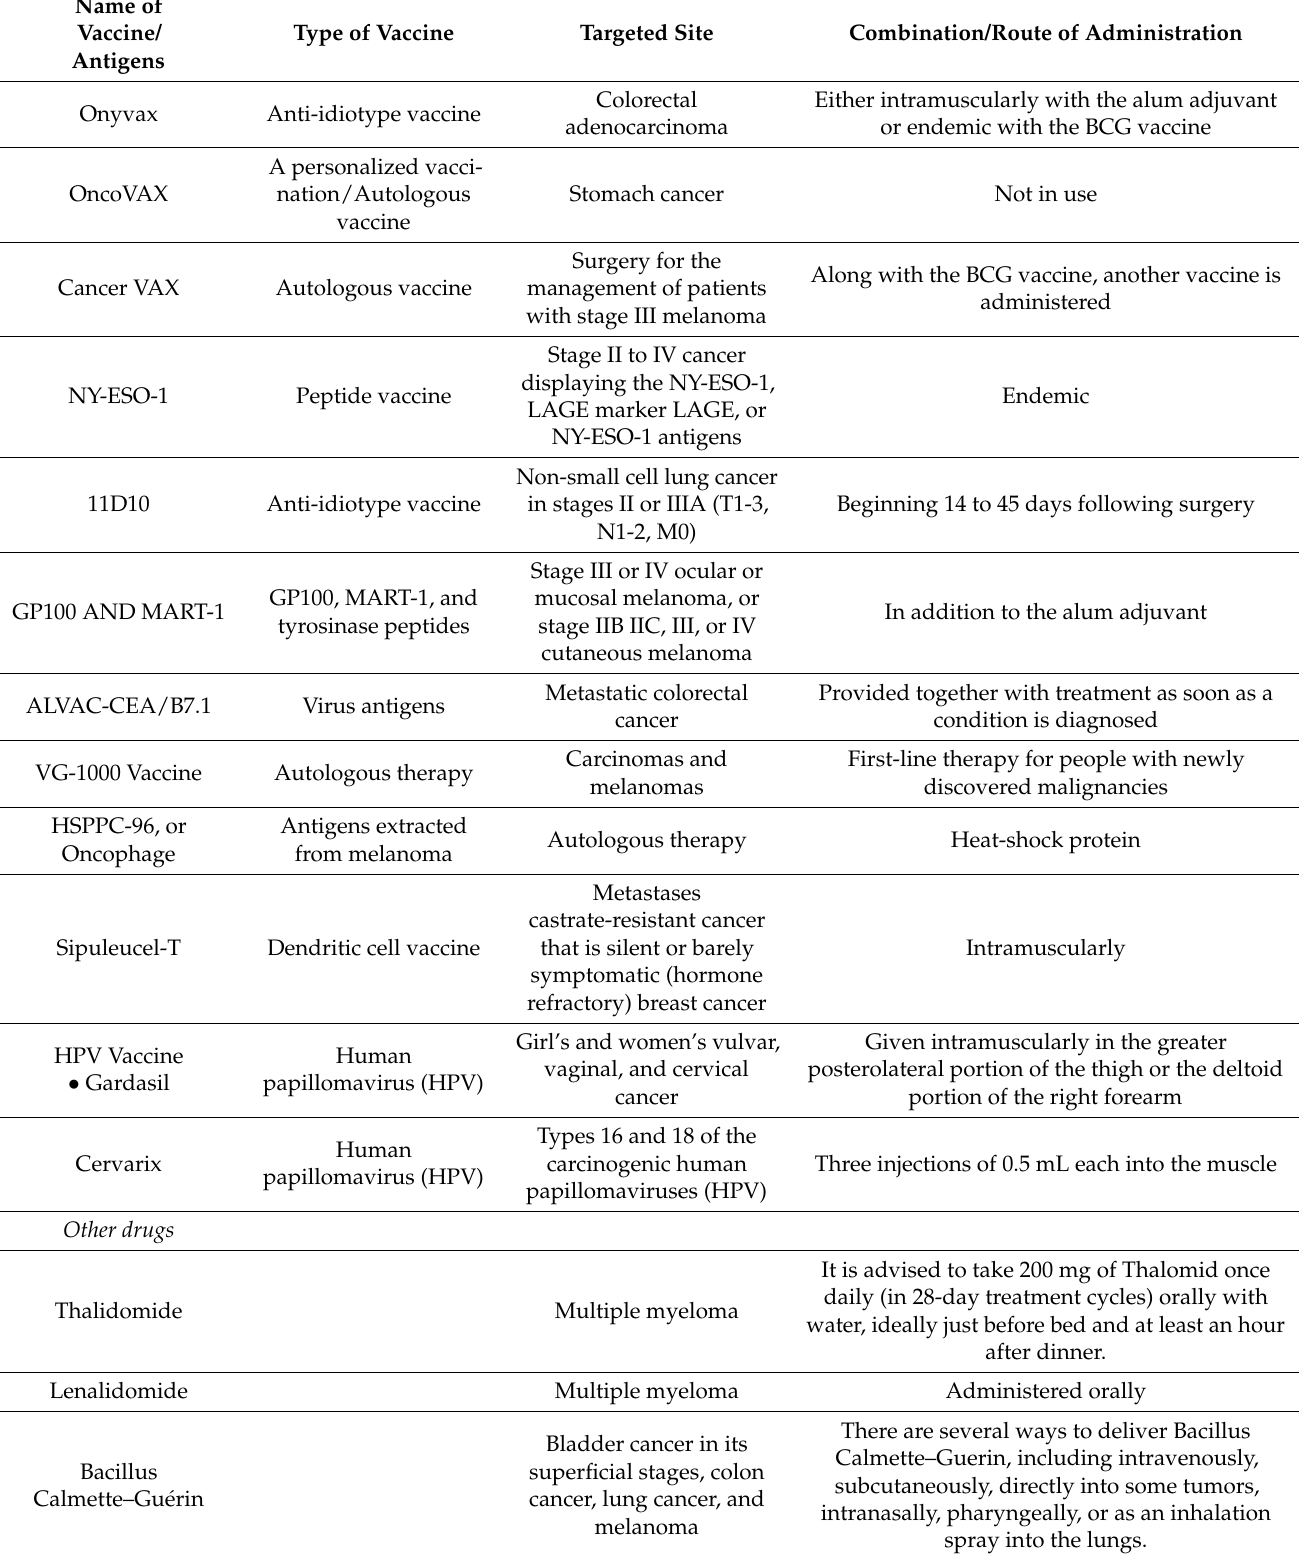
Table 2. Current therapies as cancer vaccines and antigens